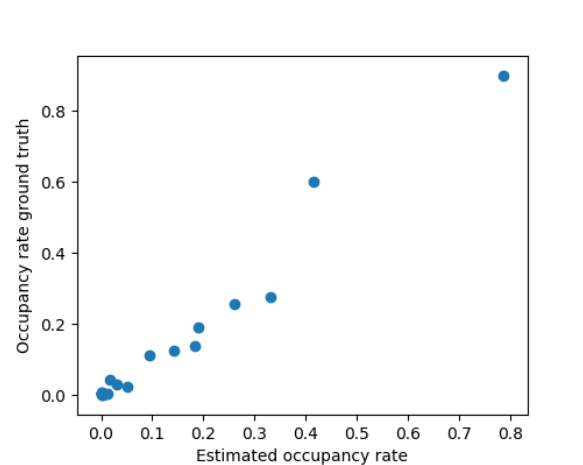
Figure 4. Occupancy rate estimation vs ground truth on the validation site using the R/DiffMedSigmaT . Correlation: +0.96.